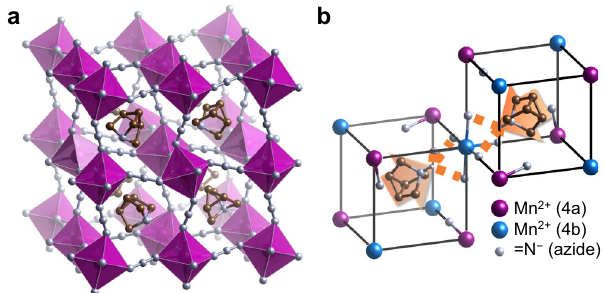
Fig. 4 Crystal structure of the low-temperature phase of AthMn(N 3 ) 3 at 300 K. a The Ath + cage cation is embedded in a cubic perovskite framework made of MnN 6 octahedra (magenta) and azide linkers. b In each octant (black frame) of the unit cell, Ath + is oriented along the body diagonal by hydrogen bonding (dotted line) with azido N, leading to an antiferroelectric alignment of the dipole moments (arrows).